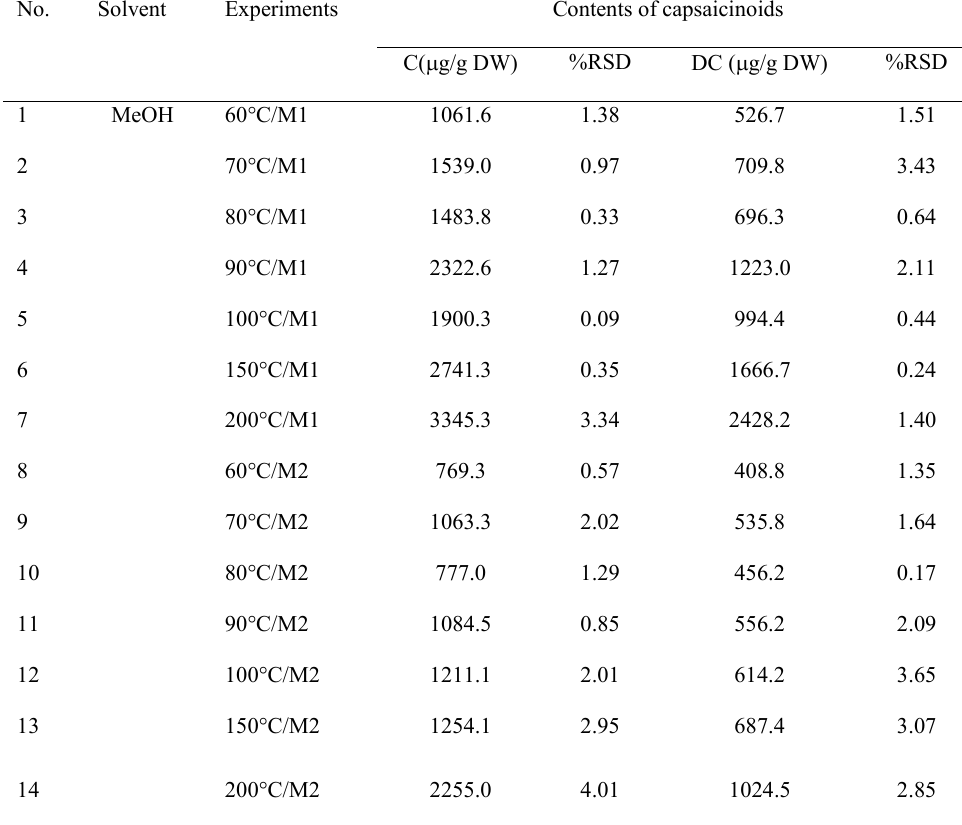
Table 2(a). Contents of capsaicinoids obtained from various conditions of ASE method.